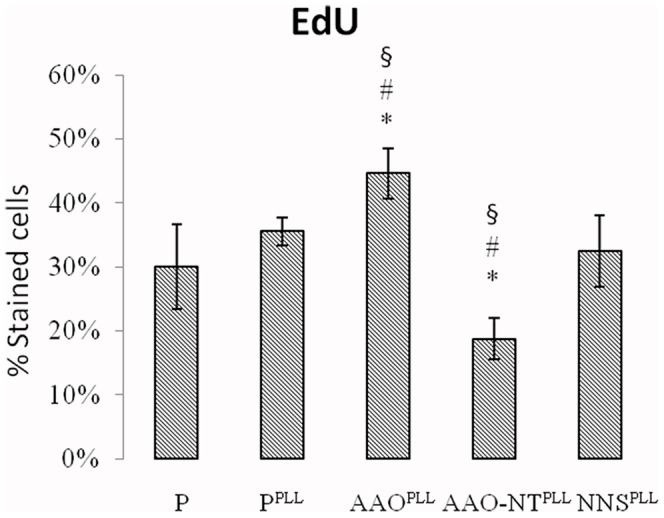
Percentage of cells positive to EdU on P, PPLL, AAOPLL, AAO-NTPLL and NNSPLL. N = 6.ANOVA followed by Bonferroni analysis, p = 2·10−8.